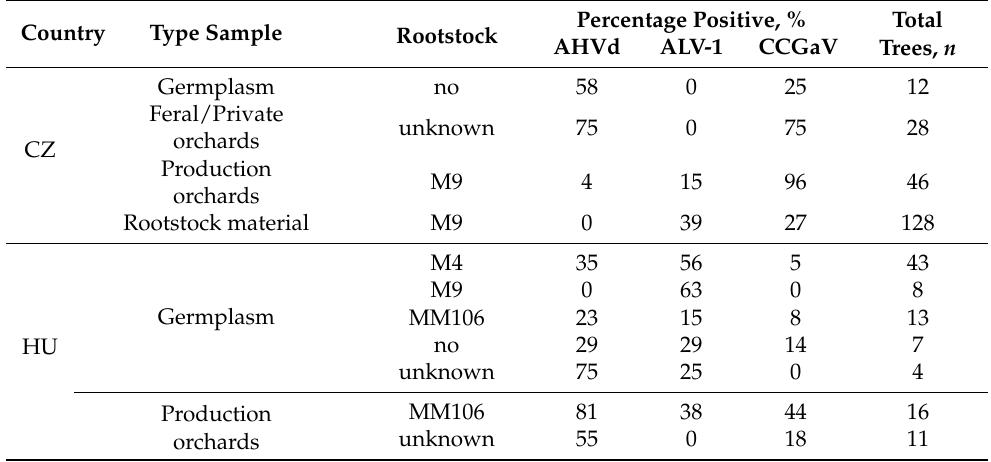
Figure 1. UpSet plots of apple hammerhead viroid (AHVd), apple luteovirus 1 (ALV-1), and citrus concave gum-associated virus (CCGaV) infections in the Czech ( A – D ) and Hungarian ( E , F ) samples uncovered by high-throughput sequencing and RT-PCR screening. Horizontal bars show the total number of viroid- or virus-positive cases. Vertical bars display the number of negative, single, and mixed infections. Pathogen names in red highlight the absence of positive cases. For example, panel A shows rootstock Czech samples, where AHVd was not detected. The total number of ALV-1 cases was higher than that of CCGaV cases (horizontal bars). Fourteen cases of mixed ALV-1/CCGaV infection were detected, while twenty and thirty-six samples were singly infected by CCGaV and ALV-1, respectively. Fifty-eight samples were tested as negatives. Table 1. Percentage of virus- and viroid-positive samples divided by categories (by country, sample type, and